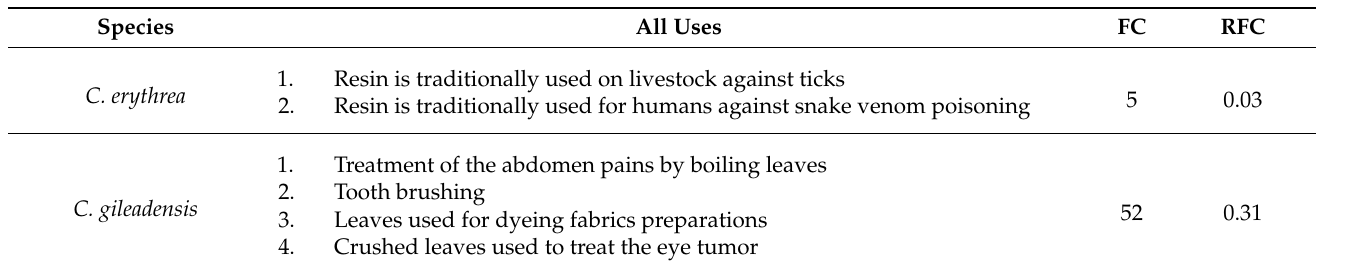
Figure 12. The relative importance of each species (RFC). Table 10. The relative importance of each species